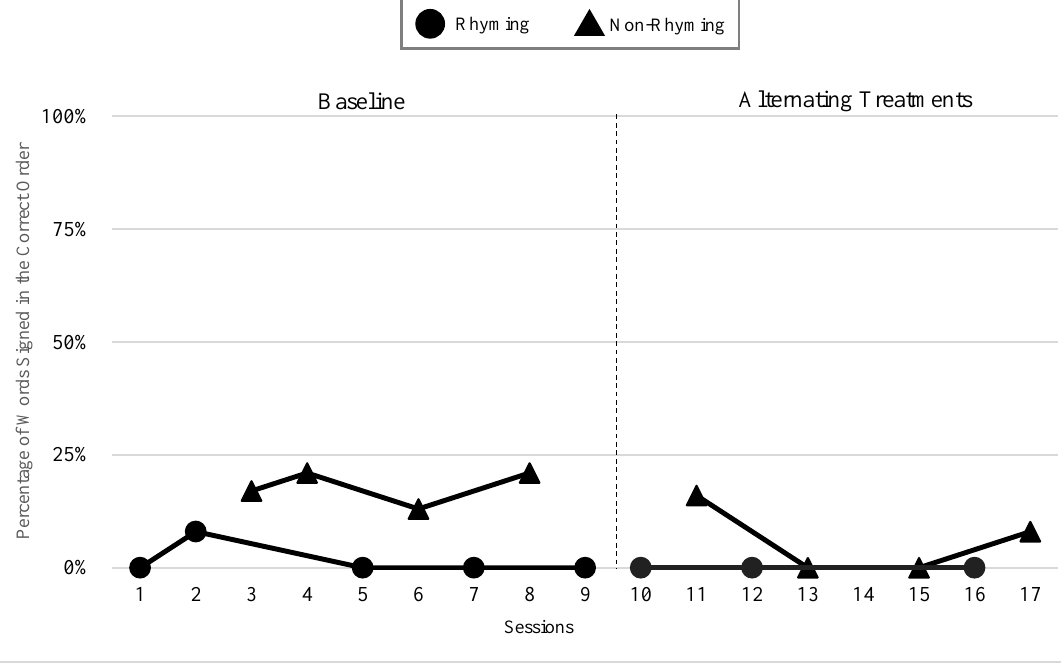
Figure 17. * Lacey’s Percentage of Words Signed in the Correct Order in Recitation. Figure 17. *Lacey’s Percentage of Words Signed in the Correct Order in